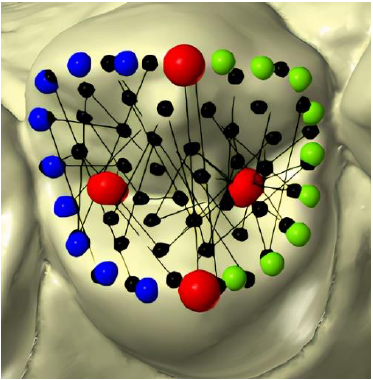
Figure 1. The distribution of landmarks (red points) and semi-landmarks (blue, green, and black points) on the tooth surface.